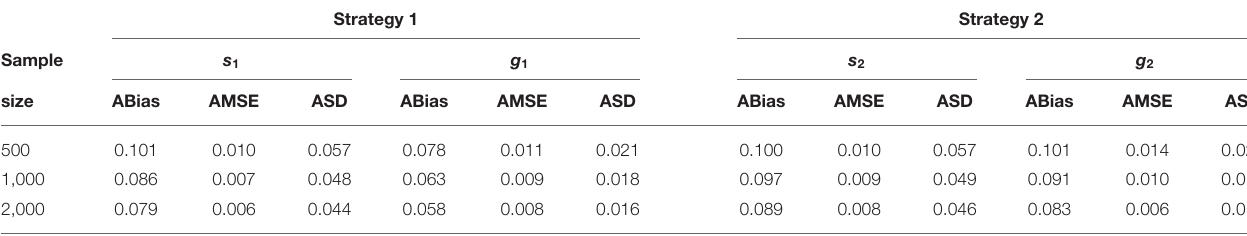
TABLE 1 | Evaluating the accuracy of the item parameters based on different sample sizes in simulation study 1. Strategy